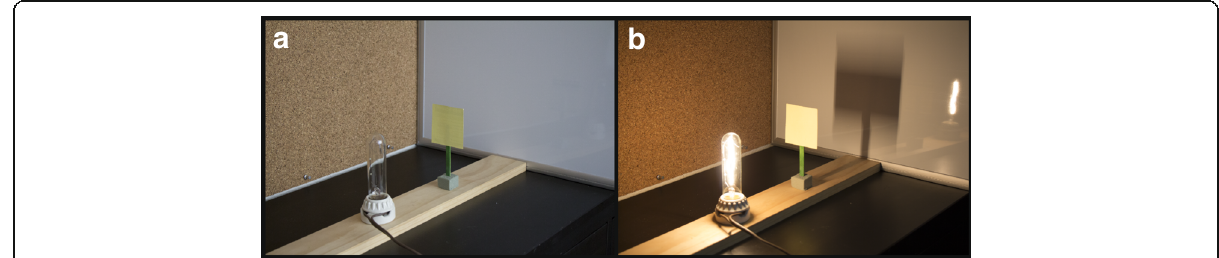
Fig. 1 First stage of the light experiment. Experimental set-up from which LAs make predictions ( a ), observation of complex shadow, different from the sharp square image that LAs typically predict ( b )